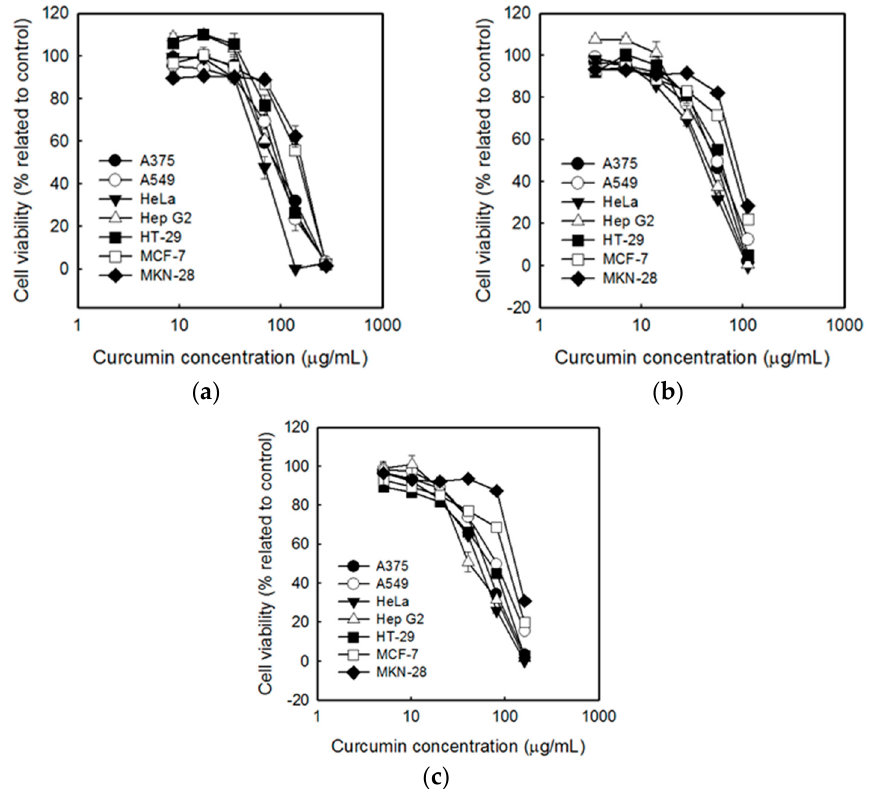
Figure 3. Effects of ( a ) curcumin, ( b ) CSCNP, and ( c ) SCNP on cancer cell viability. The cell number for 7 kinds of cells were adjusted to 2 × 10 5 cells/mL and treated with different concentrations of samples for 48 h. The cell viability was analyzed by MTT assay. Data were shown by mean ± SD of 3 independent experiments ( n = 3) with 3 technical replicates. SCNP: silica-encapsulated curcumin nanoparticles; CSCNP: chitosan with silica co-encapsulated curcumin nanoparticles. Table 2. Comparisons of IC 50 ( µ g / mL) of curcumin, SCNP, and CSCNP toward seven cancer cell lines. Cell line